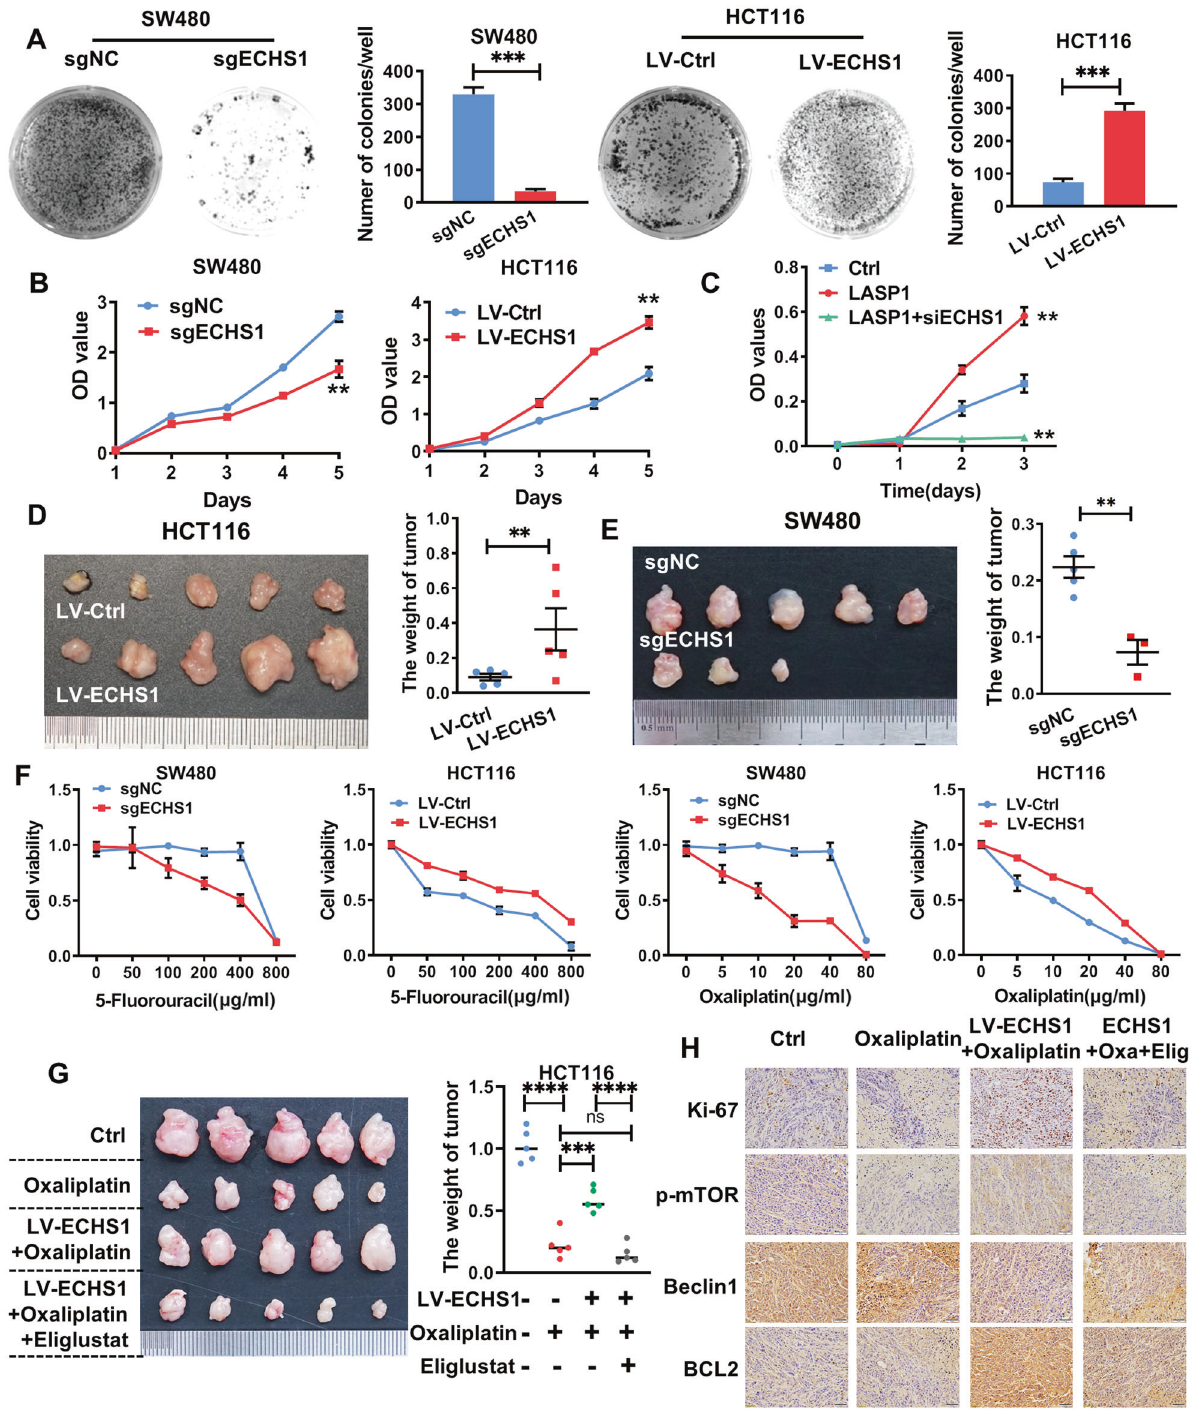
Fig. 5 ECHS1 contributes to aggressive phenotypes and drug resistance of CRC cells, both in vitro and in vivo. A Representative fi gures of the clone-formation assay for the indicated cells. Bars on the right represent the number of formed clones. B CCK-8 assay for ECHS1 loss- and gain-of-function analysis of SW480 cells and HCT116 cells on CRC cell proliferation. C CCK-8 assay for LV-Ctrl-, LV-LASP1-, and LV-LASP1 plus siRNA-ECHS1-transfected RKO cells. D , E LV-Ctrl and LV-ECHS1 HCT116 cells ( D ) and sgNC and sgECHS1 SW480 cells ( E ) were injected subcutaneously into the backs of nude mice to access tumor growth. The representative fi gures of the tumors are shown. The right bar represents the weight of the tumors. The double asterisk (**) indicates P < 0.01. F CCK-8 assay analysis of cell viability with gradient application of 5-Fluorouracil and Oxaliplatin. G LV-Ctrl and LV-ECHS1 HCT116 cells were injected subcutaneously into the backs of nude mice with or without Oxaliplatin (1.5 mg/kg) and Eliglustat (60 mg/kg) to evaluate tumor growth. A representative fi gure of the tumors is shown. The right bar represents the weight of the tumors. H Subcellular localization of Ki-67, p-mTOR, Beclin1, and BCL2 in the indicated cells was assessed through immunohistochemical staining.